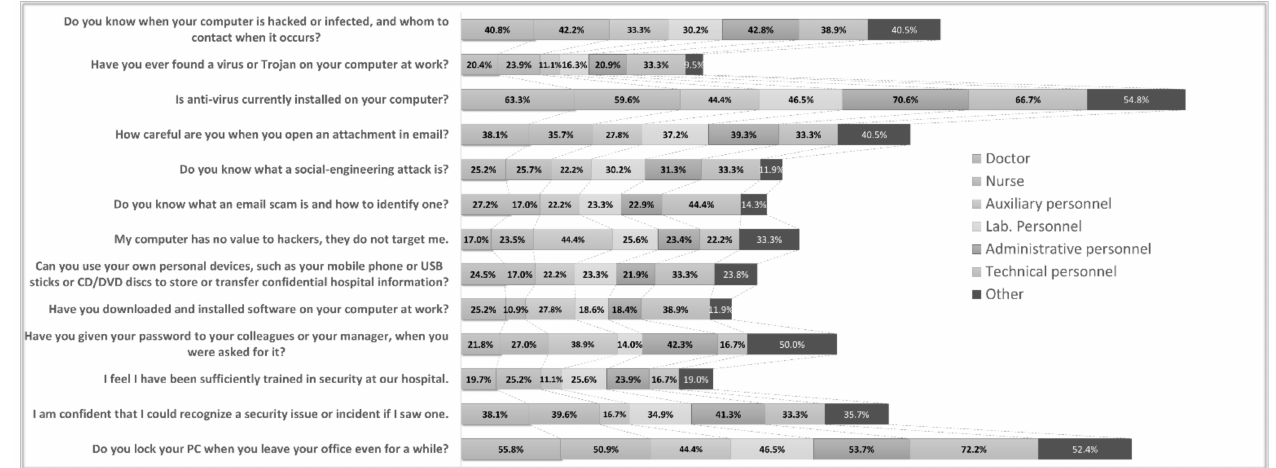
Figure 6. Digital behavior and security comprehension level of non-ICT Healthcare